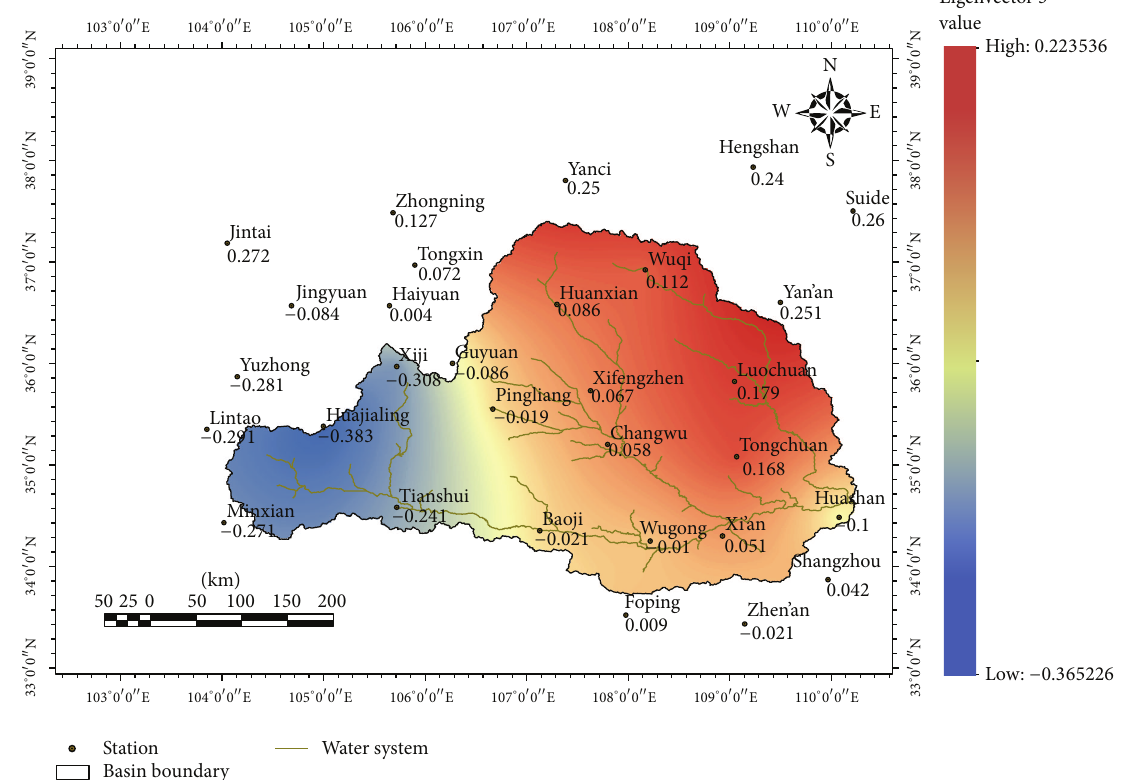
Figure 6: The eigenvector 3 values for annual precipitation in the Weihe